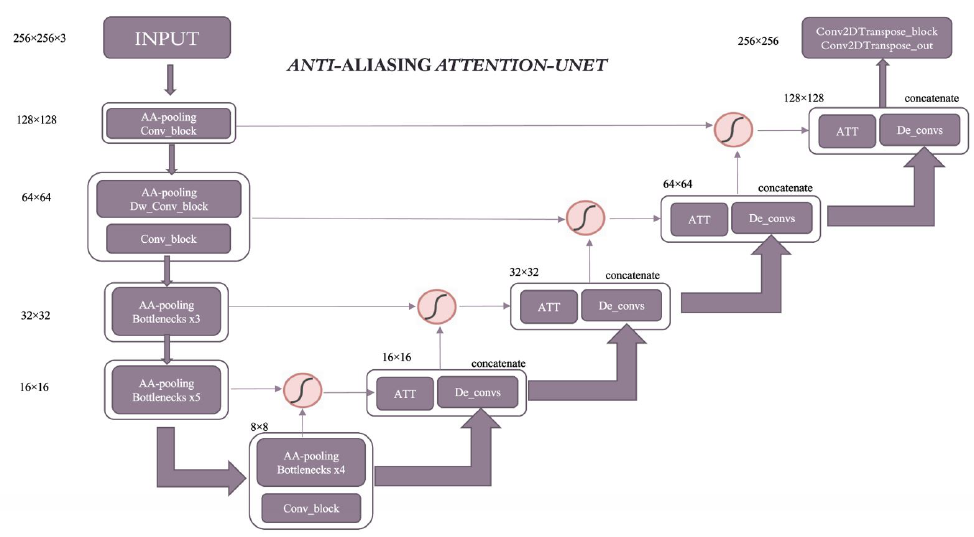
Figure 3. Anti-aliasing Attention U-net